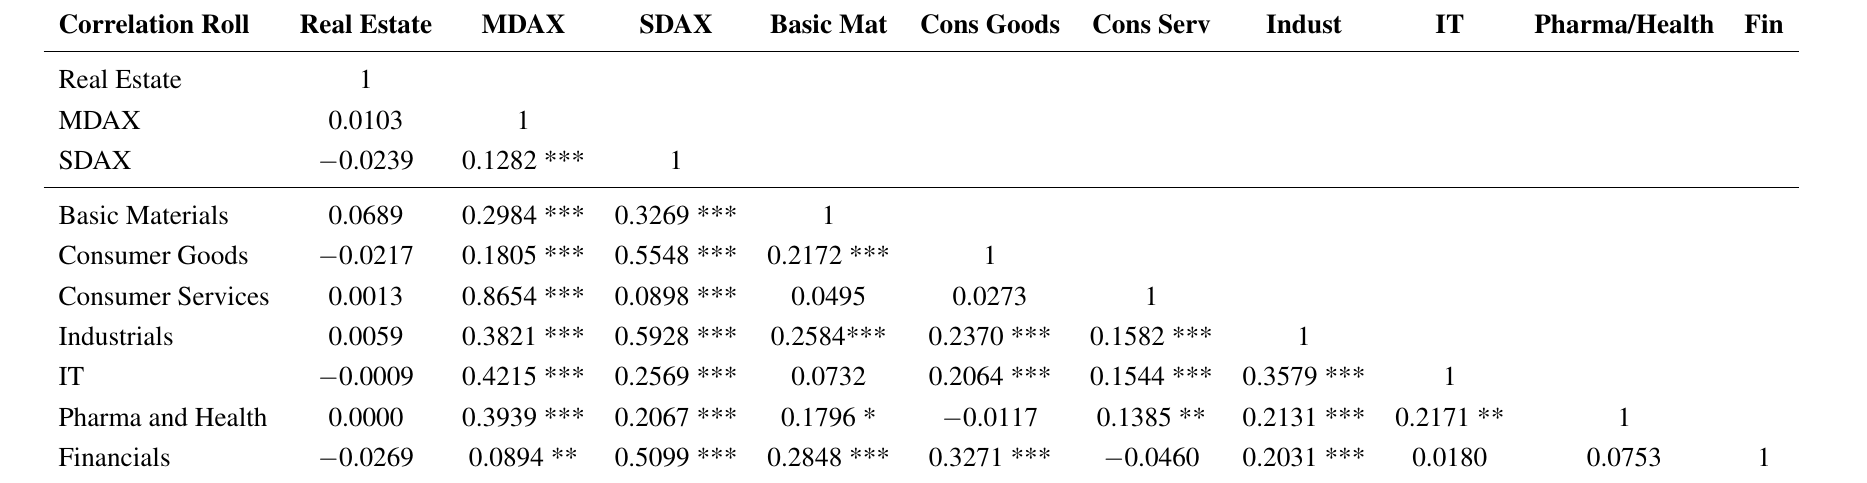
Table A3. Llorente measure correlations between several asset